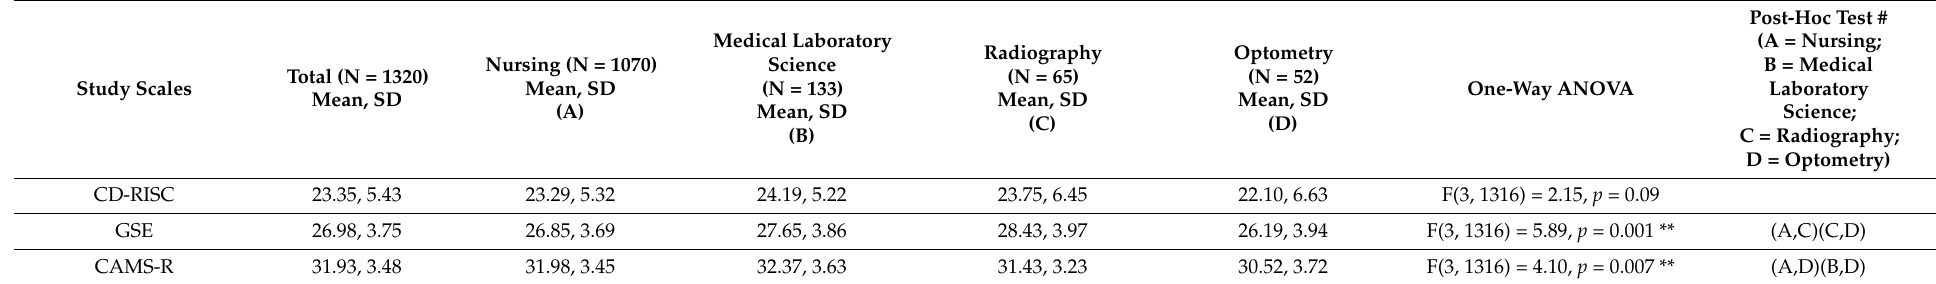
Table 2. Comparison among health care students in five study scales by one-way